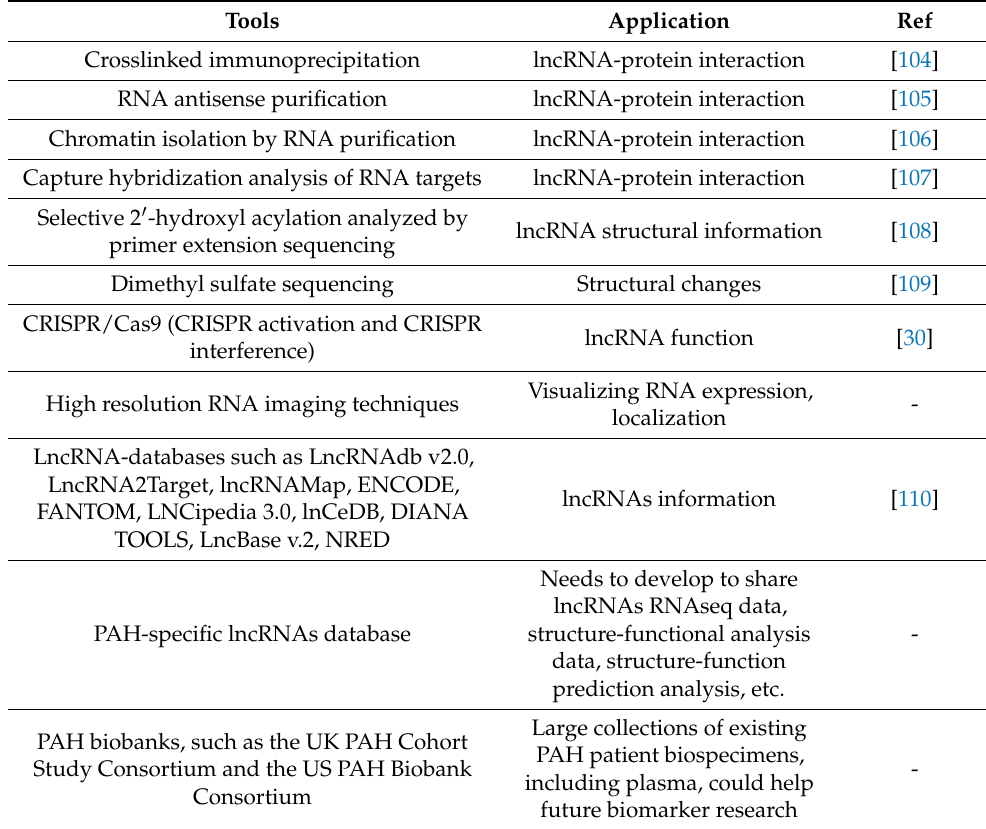
Table 2. List of tools to better understand key molecular mechanisms underlying the pathogenesis of